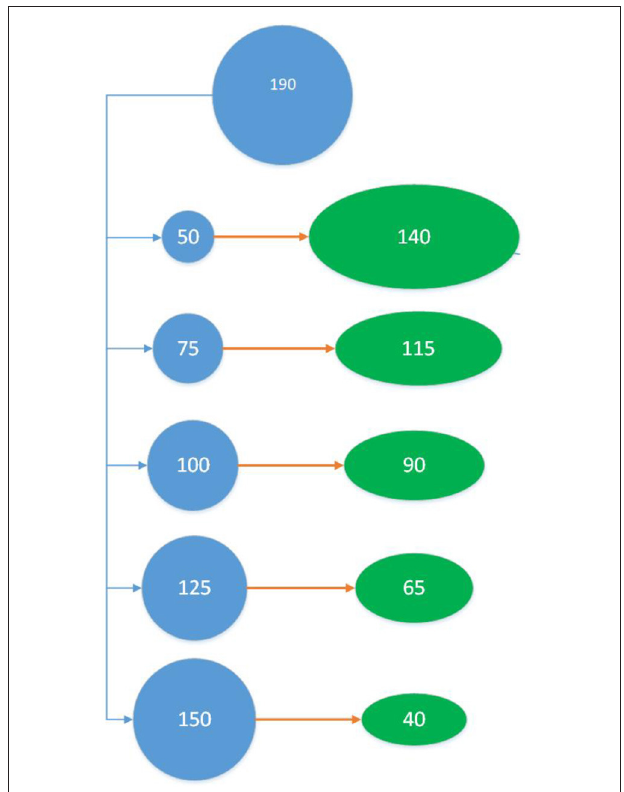
FIGURE 1 | Training-Validation (TV) Scheme: Out of 190 individuals, 50 individuals are sampled as the training set to train the model and validated using the remaining 140 individuals in the green oval. This is repeated 100 times for each training set sampling method. The entire process was then repeated for training set sizes 75, 100, 125, and 150 (which impacts the size of the validation